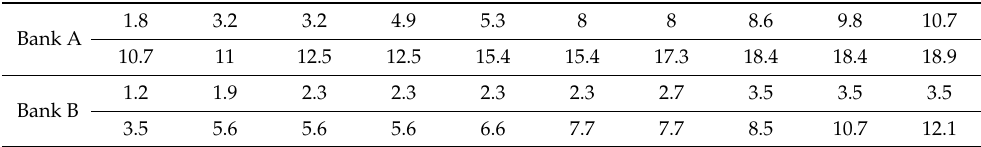
Table 8. SRS for Bank A and Bank B when n = 20, m = 20.